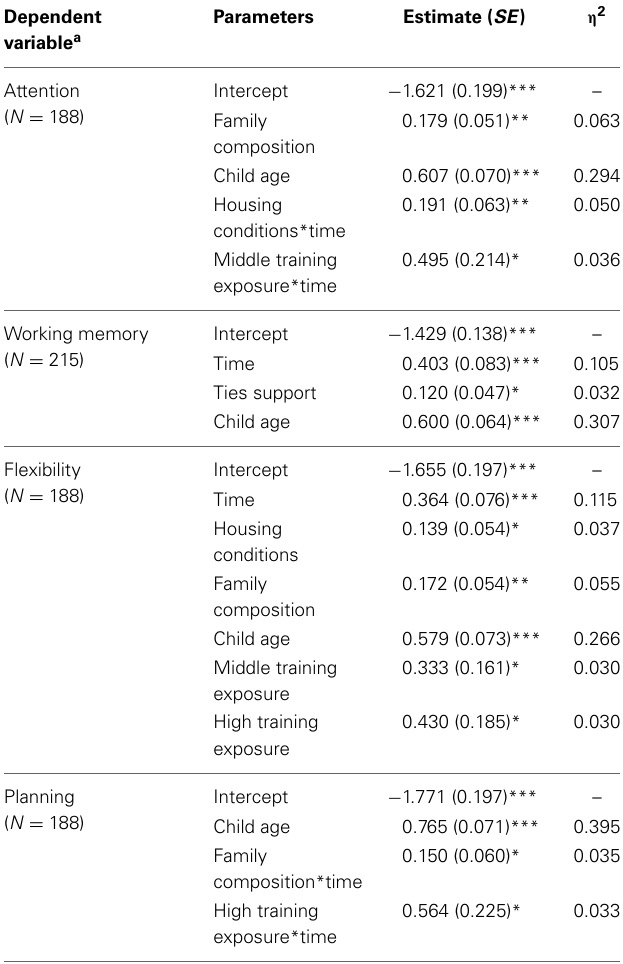
Table 15 | Results for the final model for each cognitive process in the